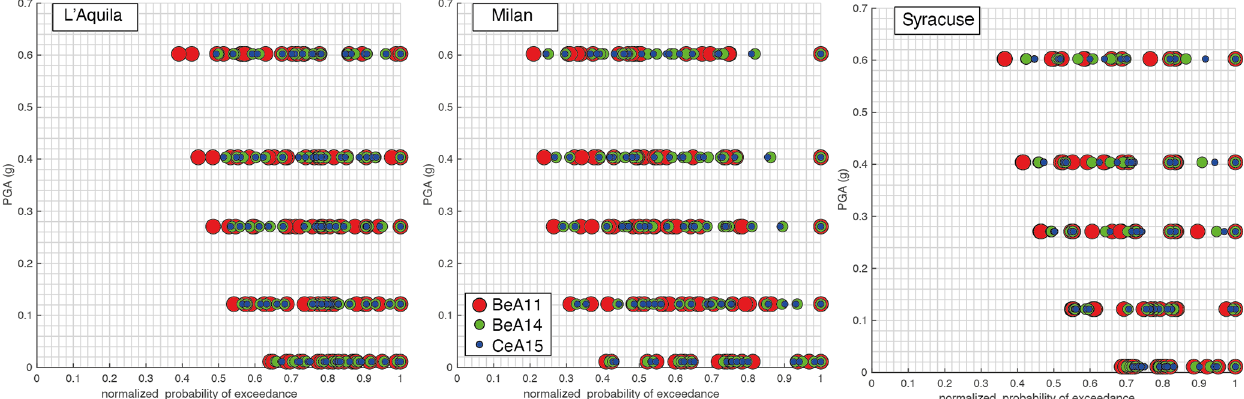
Figure 14. Relative contributions of epistemic uncertainty in ERF and GMM hazard estimates. Branches that use the same GMM are shown with three colours, red, green and blue. The x axis shows the POEs normalized to their maximum values for each PGA level. The legend in the centre panel refers to all panels. Key for all panels is as follows. BeA11: Bindi et al. (2011), BeA14: Bindi et al. (2014), CeA15: Cauzzi et al.